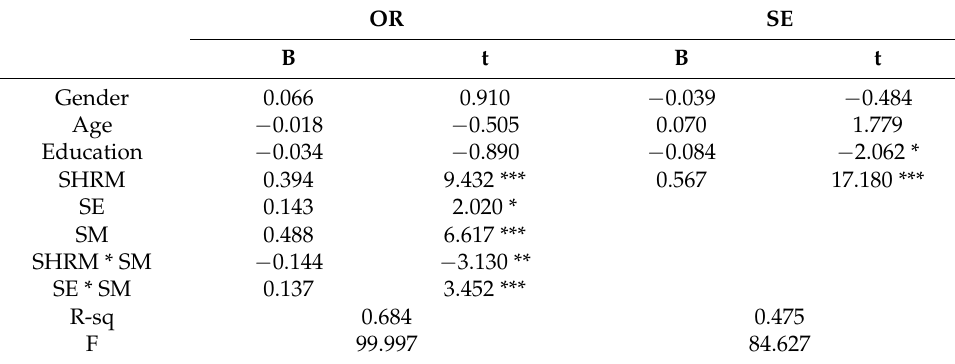
Table 6. Mediated model tests with moderation.